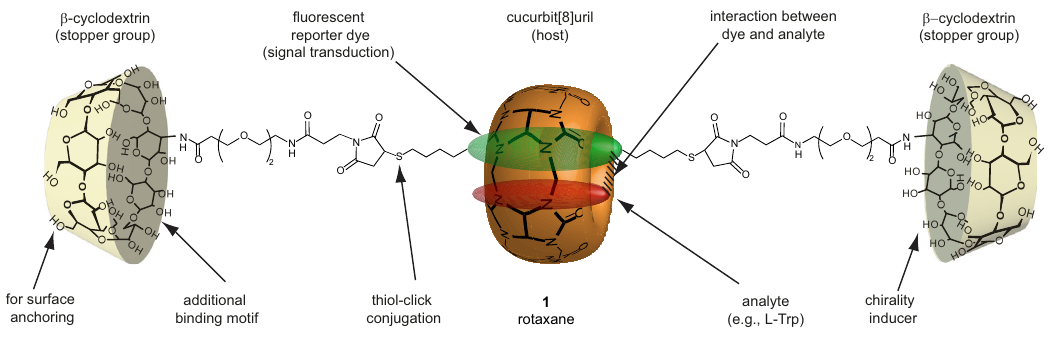
Fig. 1 | Design principle of rotaxane 1. The established binding preference and selective emission quenching of CB8 • dye complexes with electron-rich aromatic analytes were exploited for the molecular engineering of a bio fl uid-applicable chemosensor that can detect the health-relevant amino acid Trp in human blood